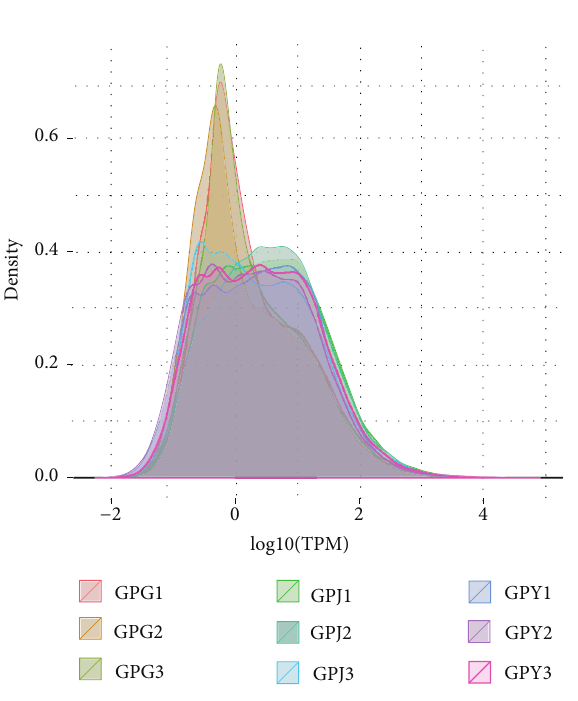
Figure 2: Density distribution of RPKM. Note: GPG: fibrous roots; GPJ: stems; GPY: leaves; RPKM: reads per kilobases per million reads.